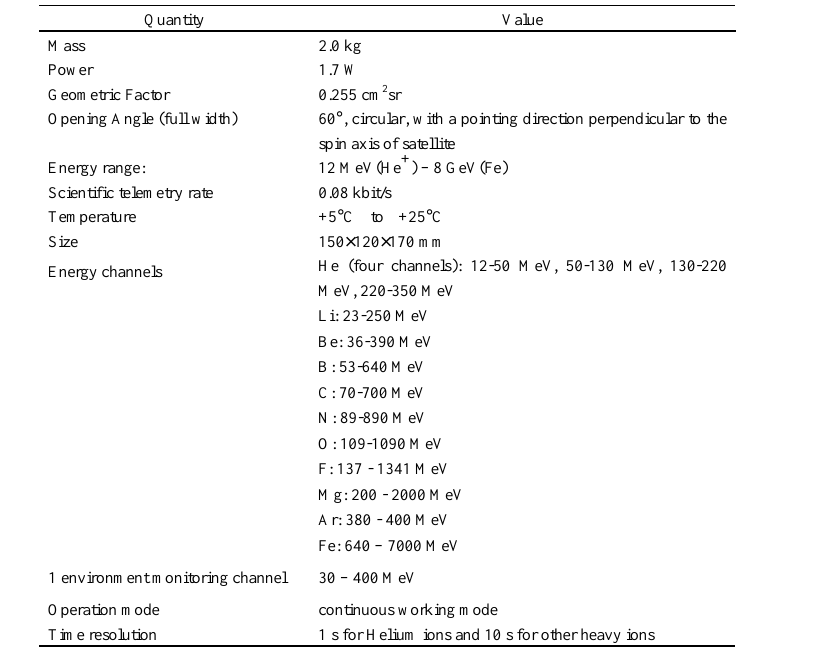
Table 4. Instrument data summary of HID.